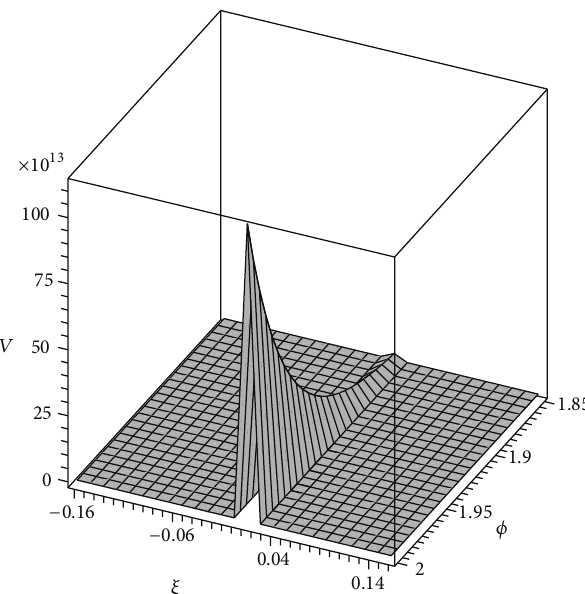
Figure 1: 𝑉 vary for different values of the 𝜙 and nonminimal coupling parameter 𝜉 for 𝑉 = 𝜙 2/3𝜉